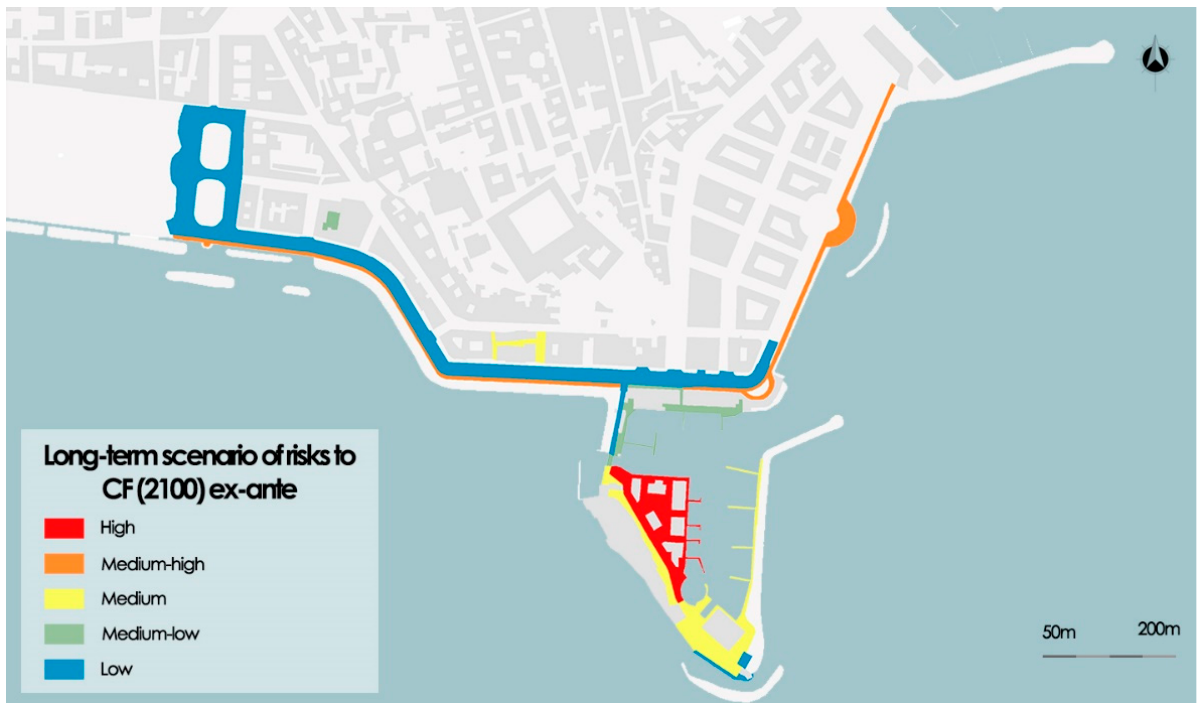
Figure 7. Long-term scenario of risk to Costal Flooding phenomenon (2100) before the application Figure 7. Long-termscenarioofrisktoCostalFloodingphenomenon(2100)beforetheapplication of NBSs. of NBSs. The damages to the atomic units were classified in 5 classes of risk elaborated by a stakeholder, based on the calibration that emerged from an economic investigation and subdivided according to the intervals identified in Table